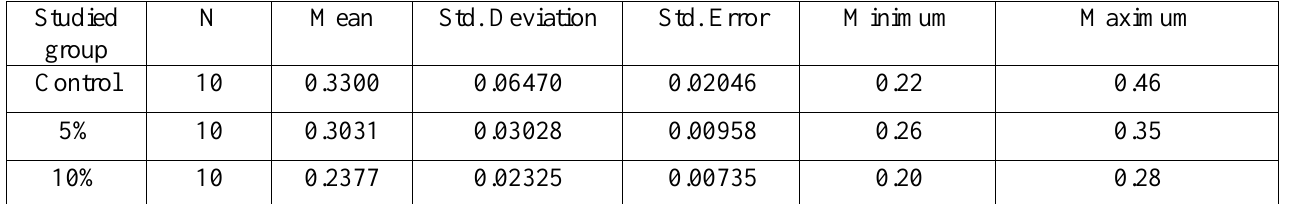
Table 3: Descriptive statistic of thermal conductivity test (W/m.°C)